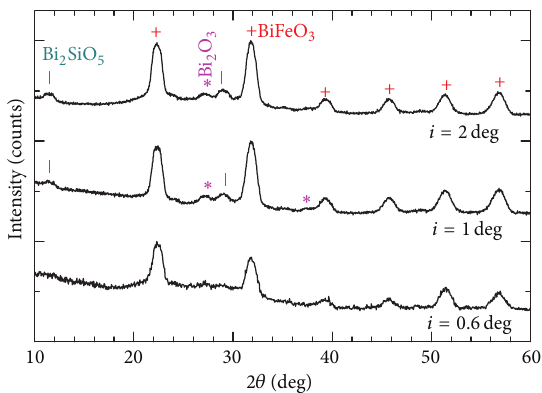
Figure 1: XRD patterns of bismuth ferrite films deposited under different sputtering gas pressures at a distance 𝑑 = 2 󸀠󸀠 .